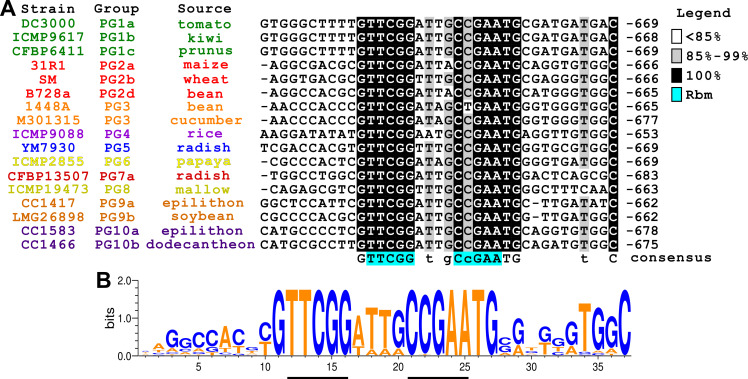
An AauR binding motif upstream of hrpRS is highly conserved in all P. syringae phylogroups that possess a canonical type III secretion system.(A) Alignment of hrpRS promoter sequences from 17 strains chosen to represent 9 phylogroups (PG) of P. syringae that carry a canonical T3SS. Strains are color coded according to phylogroup. Numbers correspond to nucleotide position relative to predicted hrpR translation start sites. Letters below alignment are consensus sequence of nucleotides based on >90% identity. Highlighted in blue is AauR-binding motif (Rbm) from aatJ promoter. (B) Sequence logo generated from multiple sequence alignments of hrpRS promoter region containing Rbm from 38 P. syringae isolates. Relative sizes and heights of the letters indicate their frequency in the sequences and information content, respectively. AT and GC content is highlighted by orange and blue coloring, respectively.